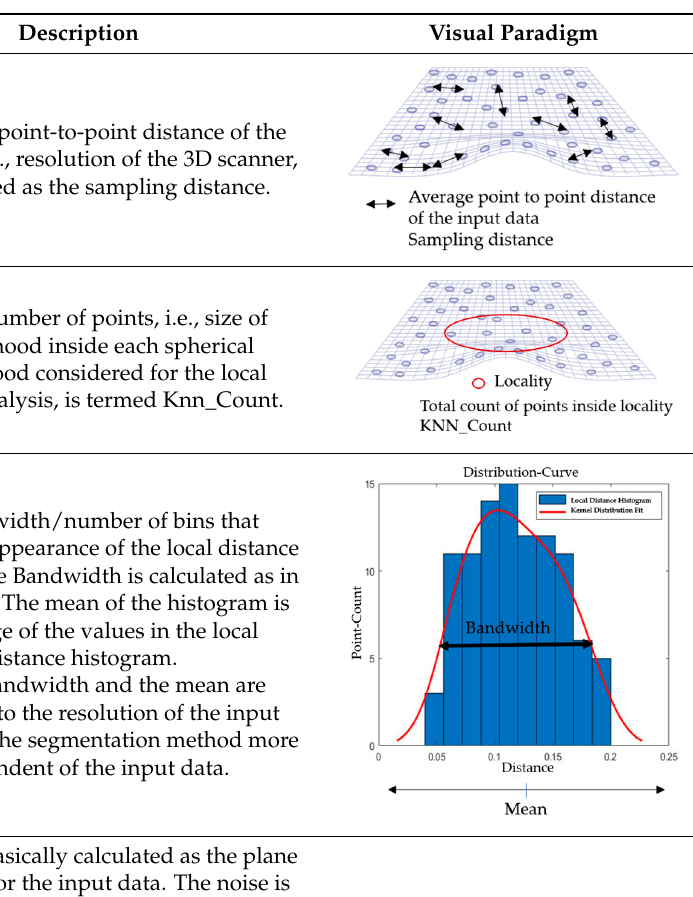
Table 1. Considered input parameters to the segmentation method.